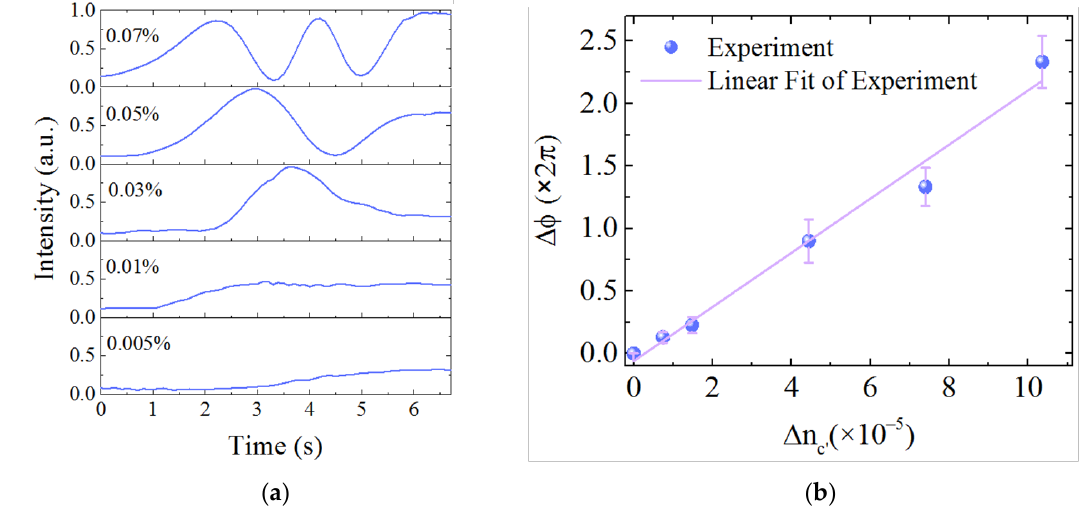
Figure 8. ( a ) Interference signals of DMSO volume ratio variety of 0.005%, 0.01%, 0.03%, 0.05%, 0.07%, respectively. ( b ) Linear fit of the experimental results with a slope of 44,364 π/RIU .